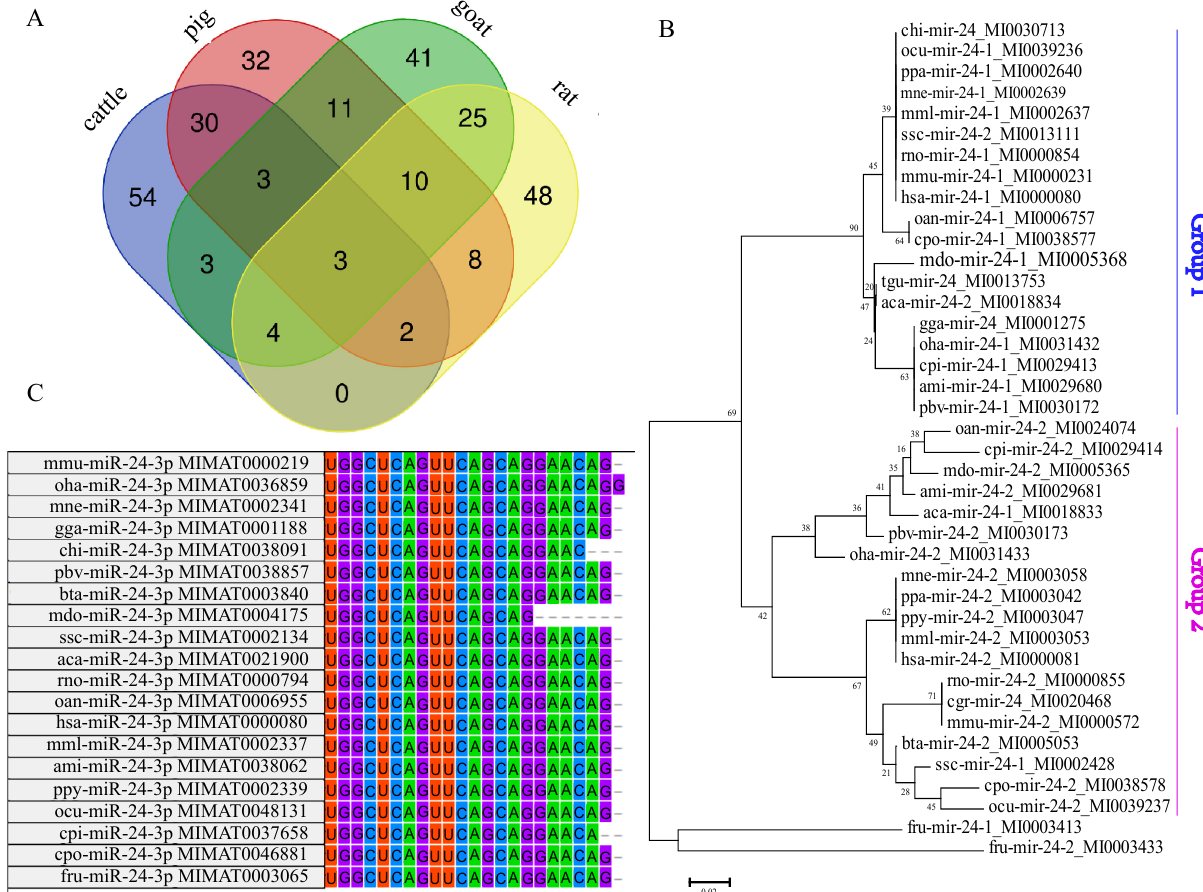
Figure 1. Identification of common miRNA in the muscle tissue of different species. ( A ) The Venn analysis of the top 100 miRNAs with high expression in the muscle tissues of cattle, pig, goat, and rat. ( B ) The phylogenetic tree of miR-24 in different species. ( C ) Multiple sequence alignment of miR-24-3p sequences in different